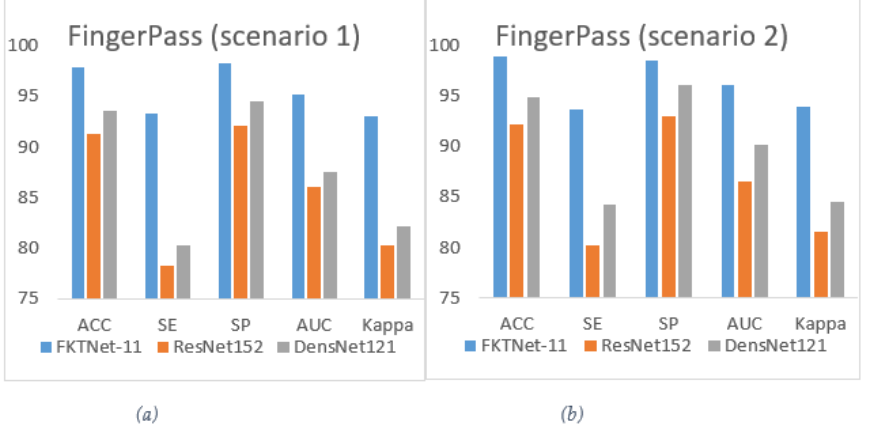
Figure 4. Comparison between FKTNET-11 and pre-trained ResNet-152 and DensNet-121 on Fingerprint dataset (4 classes) using scenario 1 ( a ) and scenario 2 ( b ).